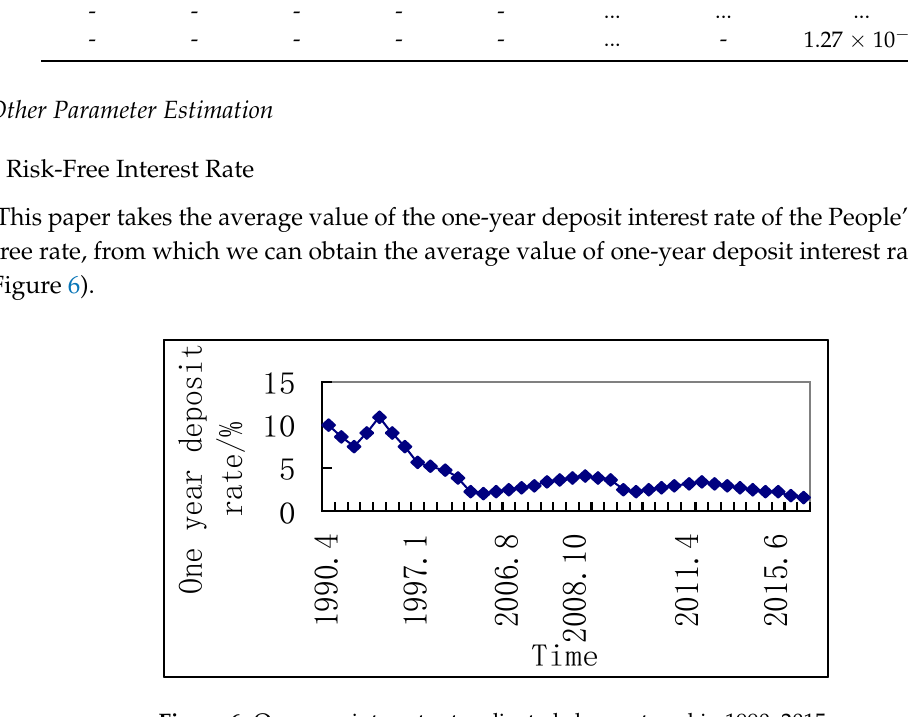
Figure 6. One-year interest rate adjusted change trend in 1990–2015.